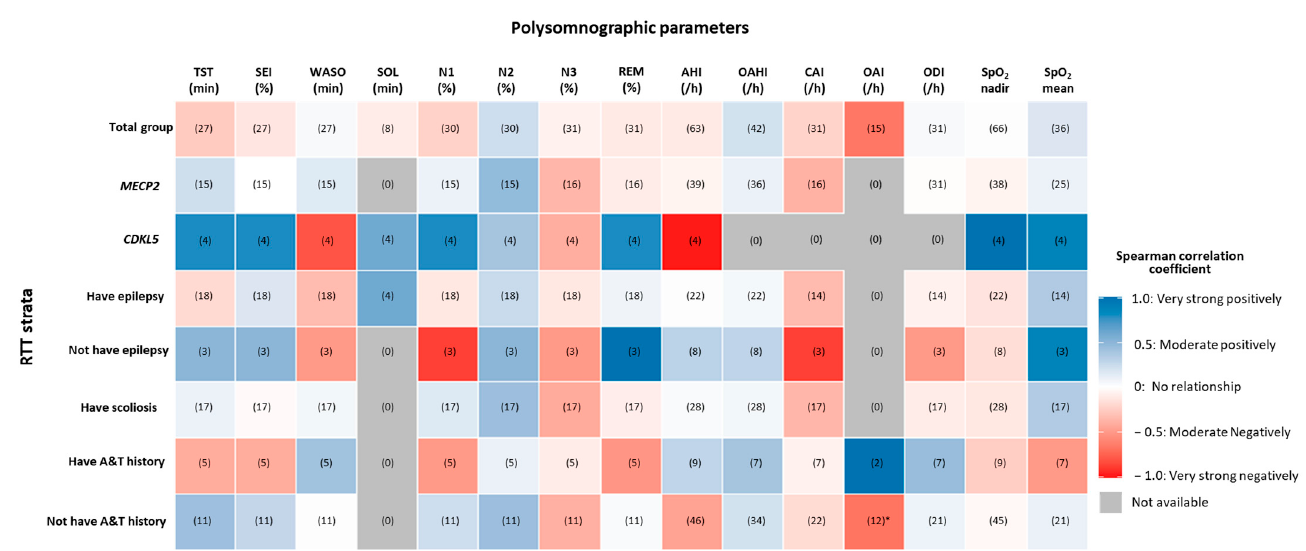
Figure 3. Spearman’s rank correlation of polysomnographic parameters with chronological age